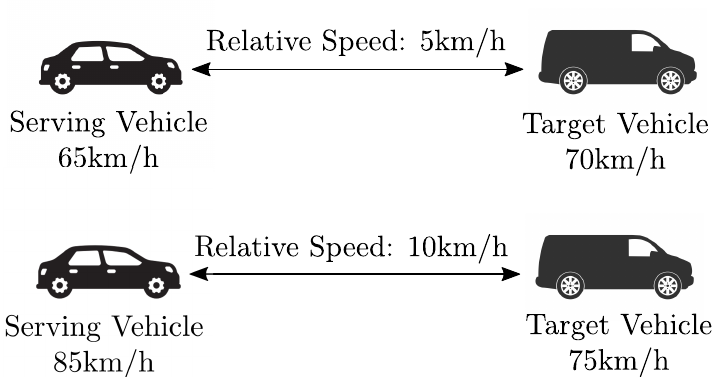
Figure 5. Examples of the relative speed between serving vehicle and target vehicle. Note that the relative speed also impacts the neighboring vehicles.